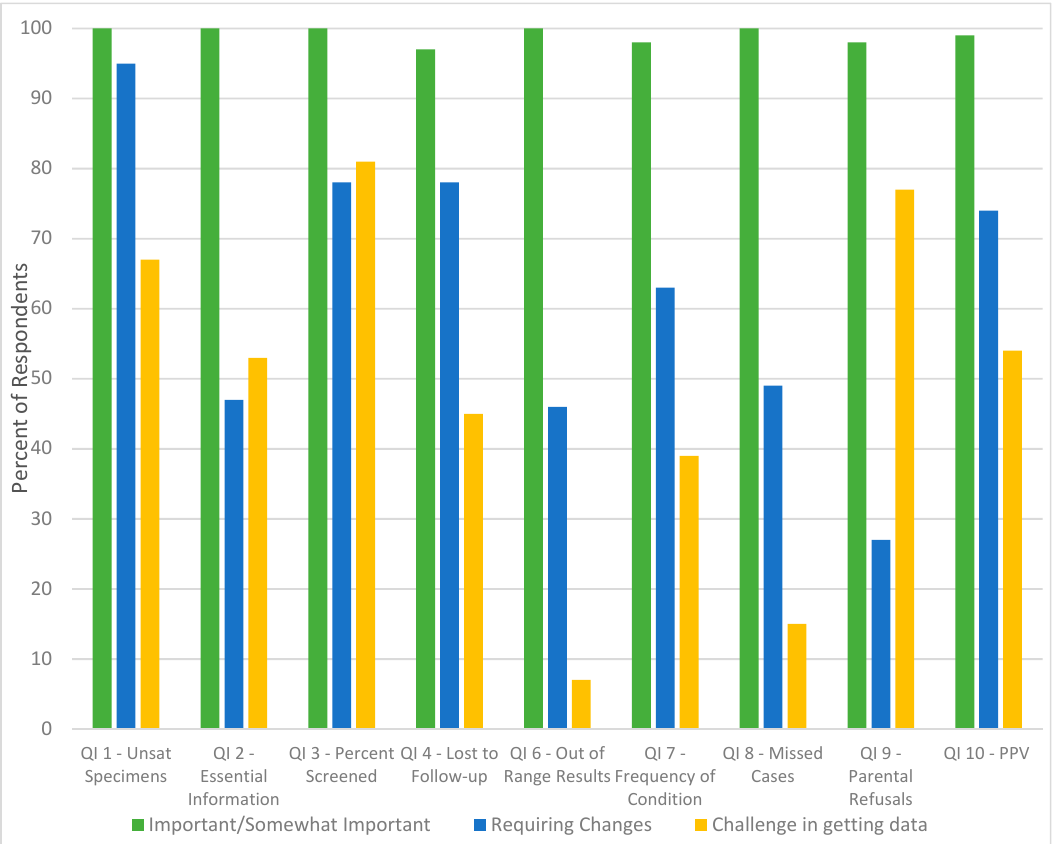
Figure 1. Electronic polling results from subject matter experts in response to importance, appropriateness, and challenges around 9 out of the ten proposed quality indicators ( n = 57). Key for the QIs in Figure 1. Quality Indicator (QI) 1: Percent of unsatisfactory specimens due to improper collection. Quality Indicator (QI) 2: Percent of dried blood spot cards with all essential information. Quality Indicator (QI) 3: Percent of eligible infants receiving a valid newborn screen. Quality Indicator (QI) 4: Rate of loss to follow-up: unsatisfactory and out-of-range. Quality Indicator (QI) 6: Rate of out-of-range results, any referral to evaluation. Quality Indicator (QI) 7: Prevalence of condition detected at birth. Quality Indicator (QI) 8: Rate of missed cases (false negatives). Quality Indicator (QI) 9: Percent of parental refusals. Quality Indicator (QI) 10: Positive predictive value (PPV) of out-of-range